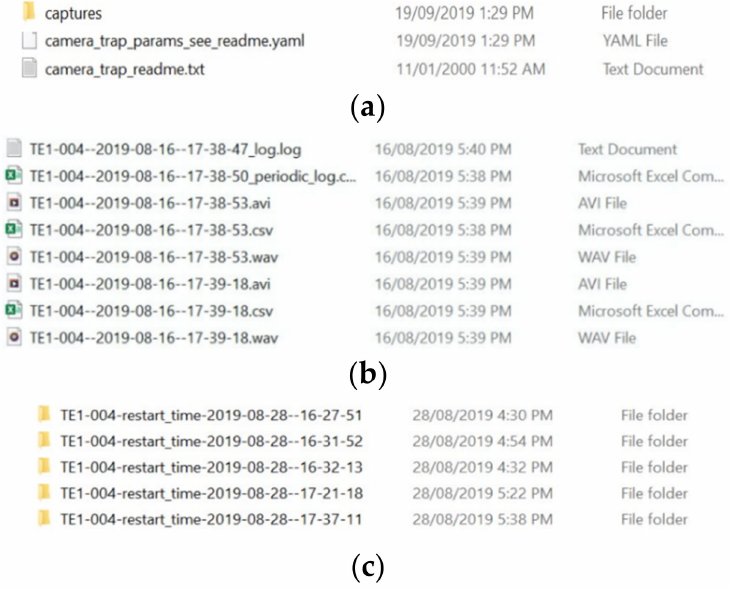
Figure A3. ( a ) File formats on USB memory, ( b ) contents of capture folder on USB, and ( c ) contents of restart folders on USB